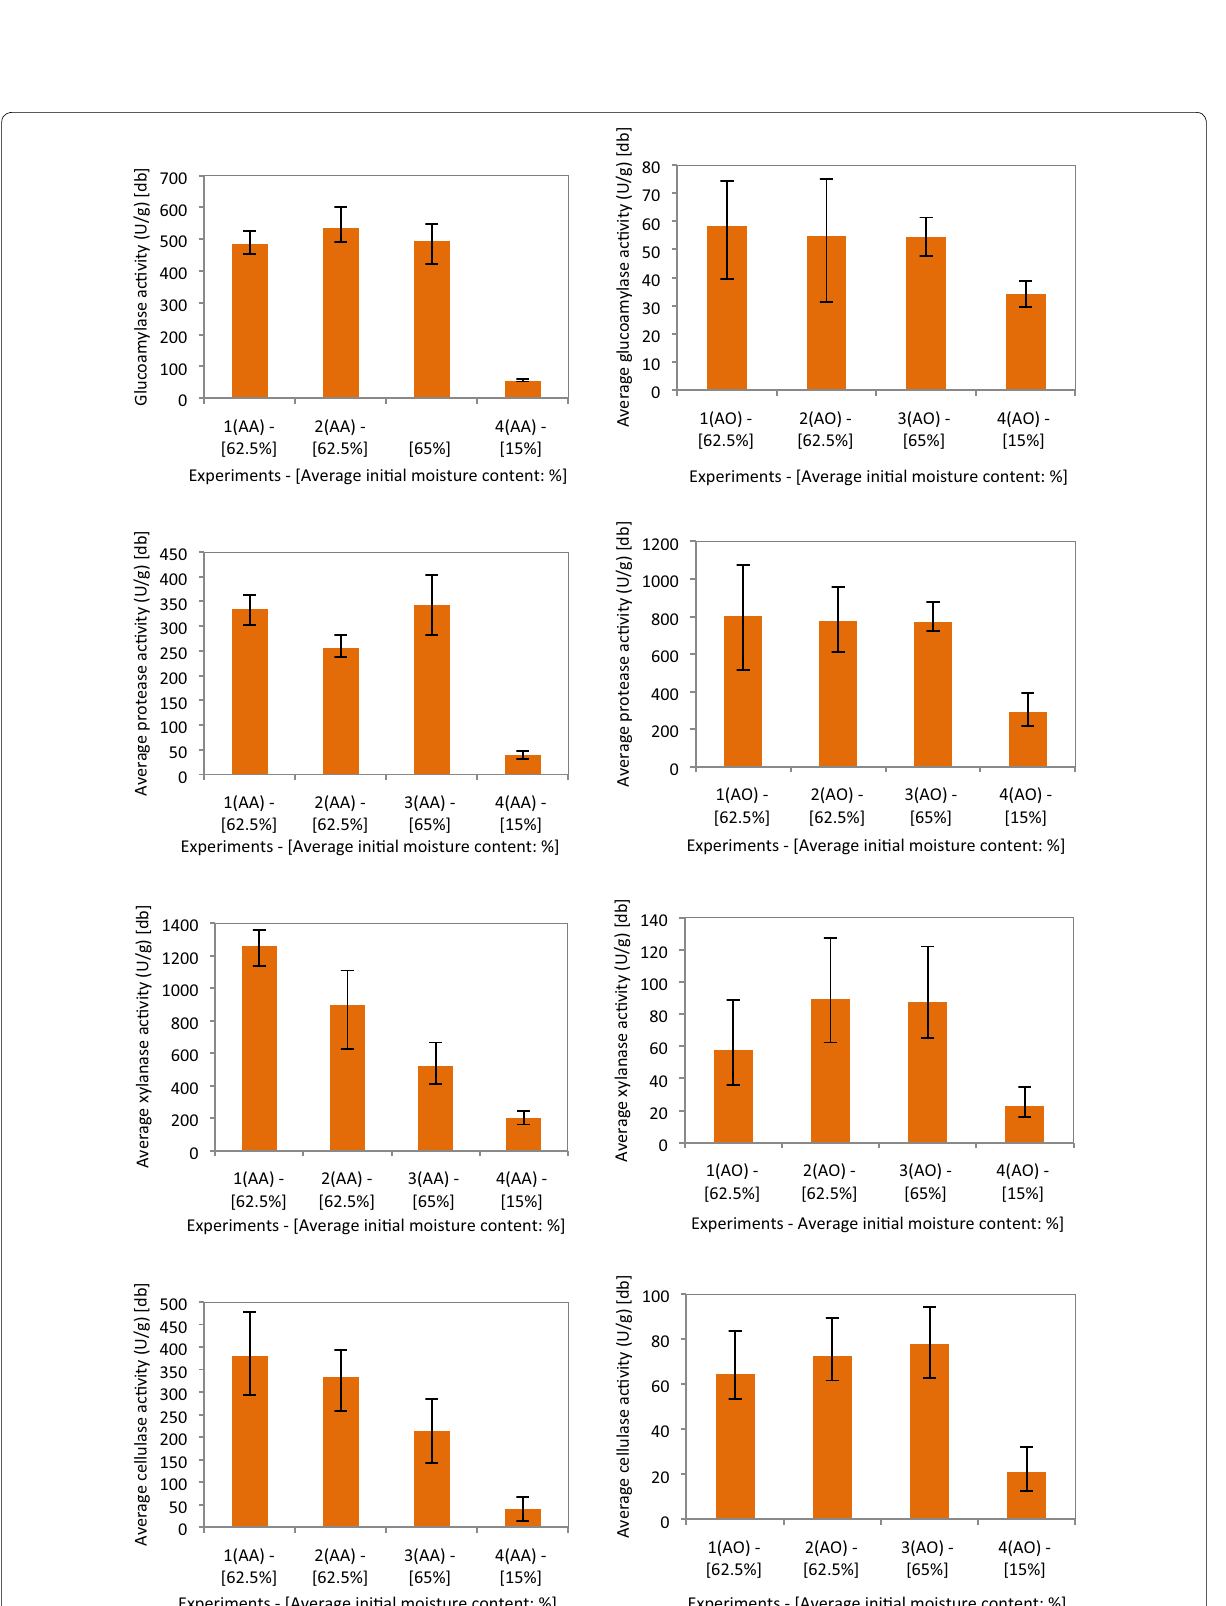
Fig. 9 Fermentation summary of average enzymes production from multi-stacked circular tray solid-state bioreactor with different initial moisture content arrangements. [AA]— A. awamori and [AO]— A. oryzae . The results are shown as mean three ( n =